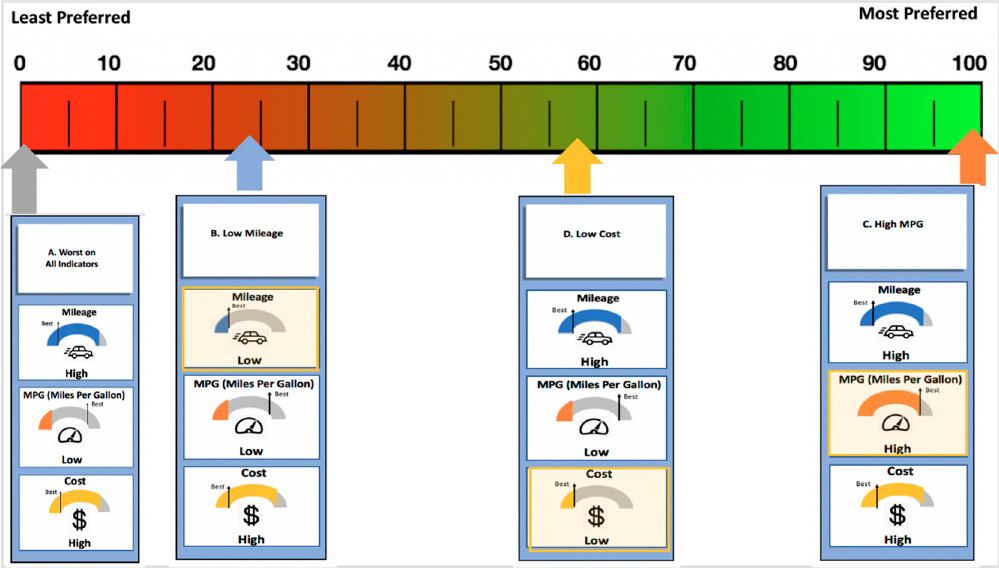
Figure 3. Example of the activity completed by participants. Scenarios (cards) are placed in the desired order on a scale of 0 (least preferred) to 100 (most preferred) based on individual and group preferences. From the results of the choice tasks, trade-o ff weights for each attribute are calculated